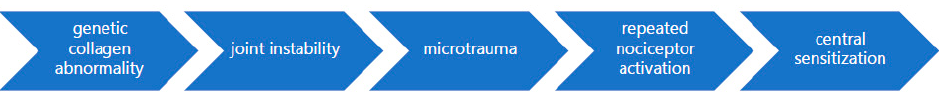
Figure 1. Integration of theories of etiology of pain in Ehlers–Danlos syndromes (EDS) described by Gedalia and Brewer (1993) [23], Ferrell and colleagues (2004) [29], and Rombaut and colleagues (2015)